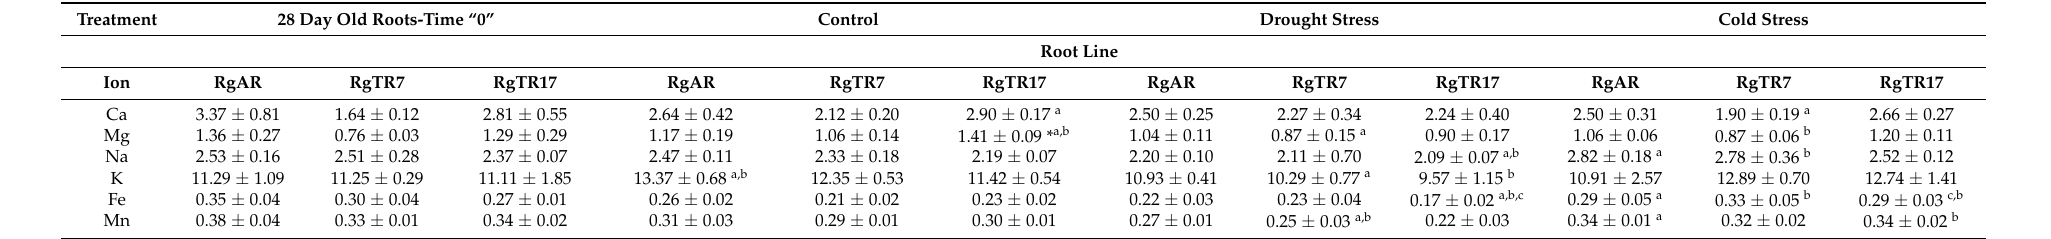
Table 2. Ions concentration [ppm/g DW] in R. graeca roots cultivated under various